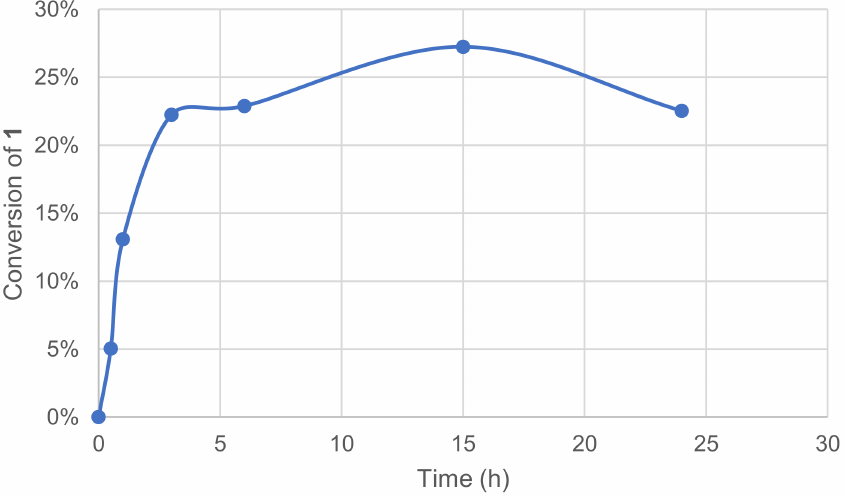
Figure 6. Effect of time reaction on the conversion of 1 in the laccase-catalyzed oxidation (LA 10% w/w , HOBt 20 mol%, acetate buffer pH5 0.25 M, O 2 atmosphere, incubation 40 ◦ C, 200